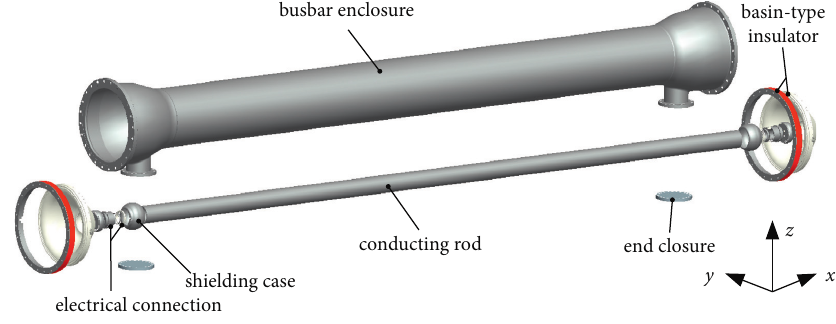
Figure 2: Explosion diagram of the busbar model. Table 1: Dimension parameters of the busbar enclosure.